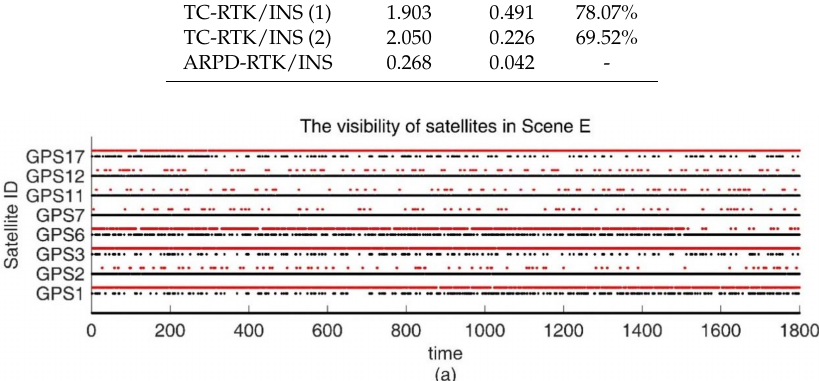
Table 4. Trajectory error and fix rate for three RTK algorithms on the simulation Scene E (Unit: m). Algorithm